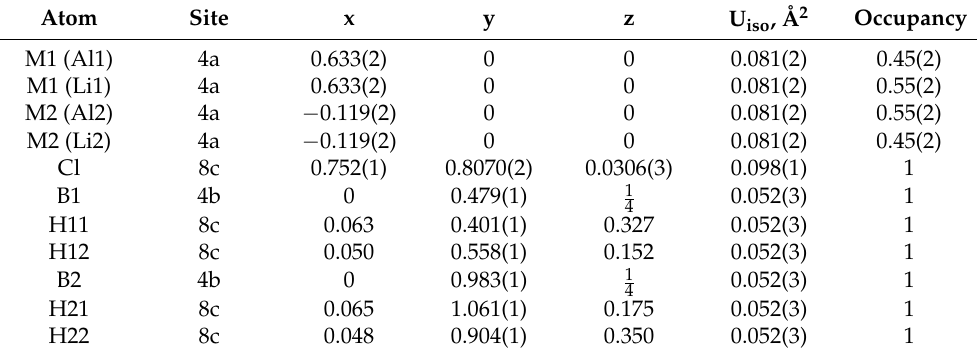
Table 2. Crystallographic data for LiAl(BH 4 ) 2 Cl 2 compound determined from Rietveld refinement of the structure model obtained using FOX: space group C222 1 (#20), a = 11.6698(5) Å, b = 8.4724(4) Å, c = 7.5116(3) Å. Fit residuals (not corrected for background) Rp = 4.78%; Rwp = 6.49%.